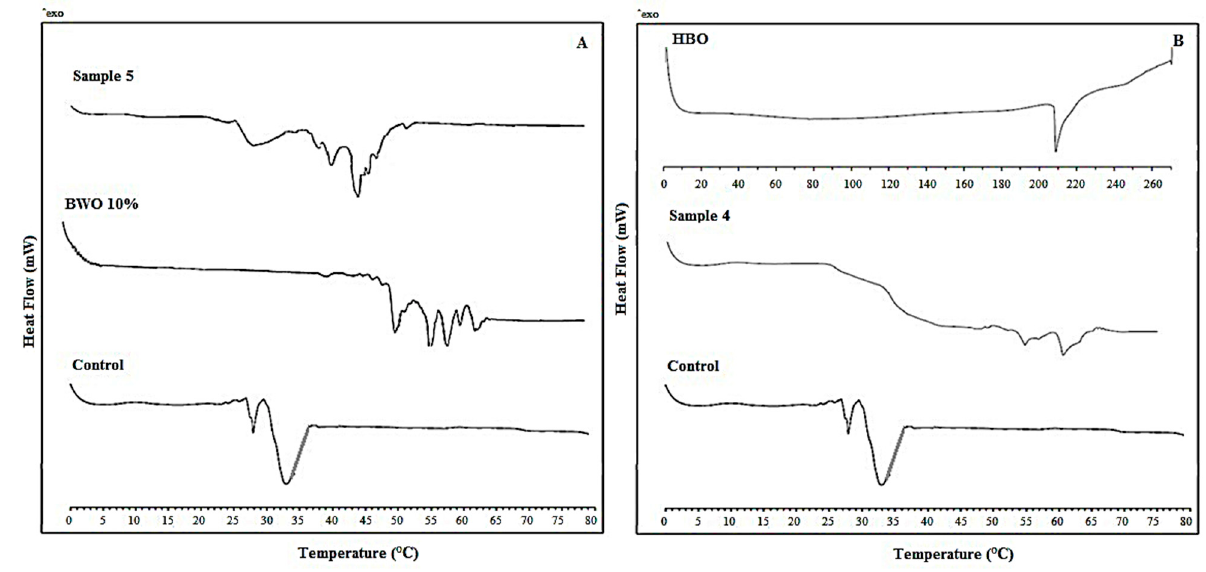
Figure 1. ( A ) melting profile of control margarine and beeswax oleogel 10% and sample 5. ( B ) Melting profile of control margarine and hydrocolloids-based oleogel (HBO), and sample 4.